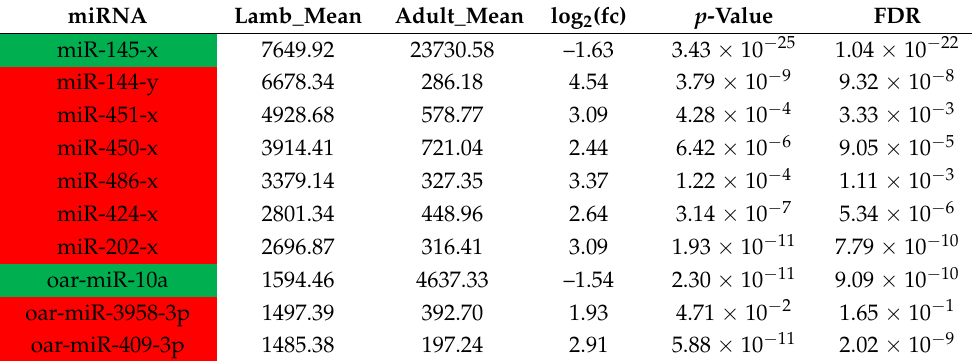
Figure 1. miRNA expression analysis of the ovaries of lamb and adult sheep under superovulation treatment. ( A ) Sequence length distribution for miRNA sequencing. ( B ) Principal component analysis (PCA) of expression of miRNA values in the lamb and adult sheep libraries. ( C ) Screen of differentially expressed miRNAs. ( D ) Heat map analysis of differentially expressed miRNAs. Table 2. Top 10 highly and differentially expressed miRNAs in the lamb and adult sheep libraries.